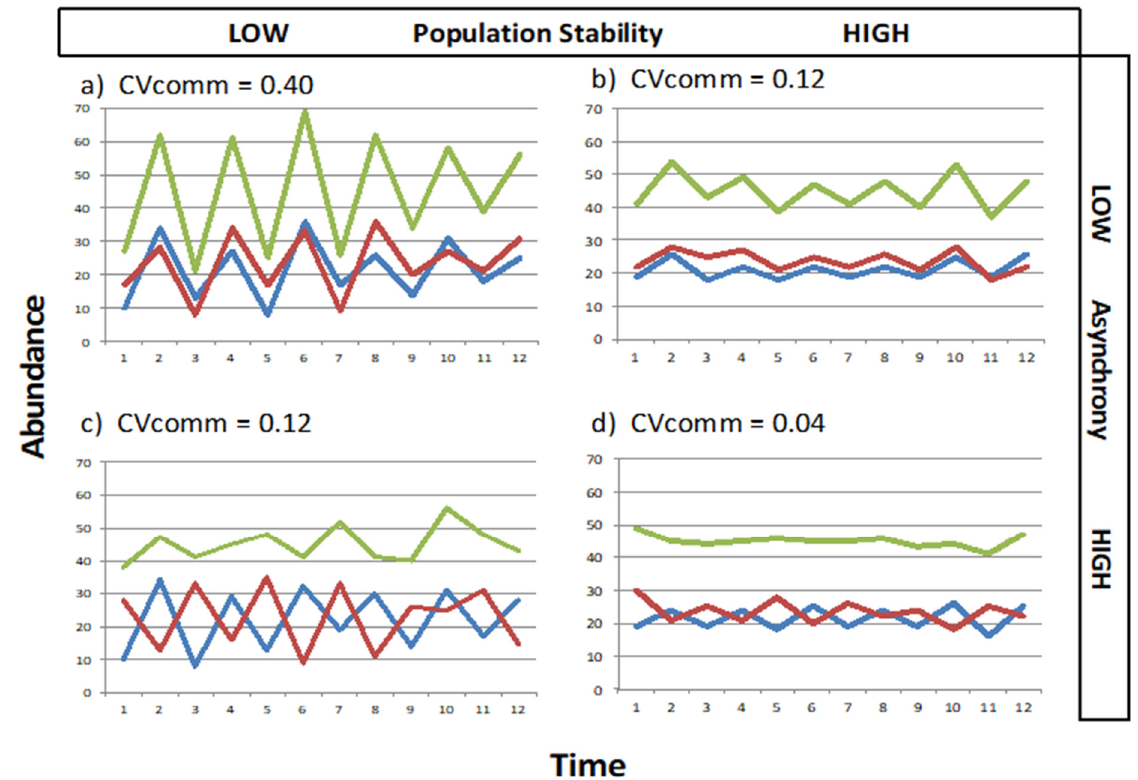
Figure 1. Modelled abundances of two species (in red and blue) and their combined “community abundance” (in green), showing how community stability can be affected by the balance between population stability and asynchrony. ( a ) Low population stability and low asychrony, ( b ) high population stability and low asynchrony, ( c ) low population and stability high asynchrony, ( d ) high population stability and high asynchrony. CVcomm can range from 0 to 1 and is the inverse of community stability. The Temporal mean for each community ( µ , pooled abundance) was 45. The Standard deviation ranged between 3.0 and 3.5 for high population stability and between 9.50 and 10.0 for low population stability. Asynchrony is measured as 1 − ϕ , with high asynchrony ranging between 0.8 and 0.9 and low asynchrony ranging between 0.1 and 0.2. Data used for these models can be found in Supplementary Materials Table S1.